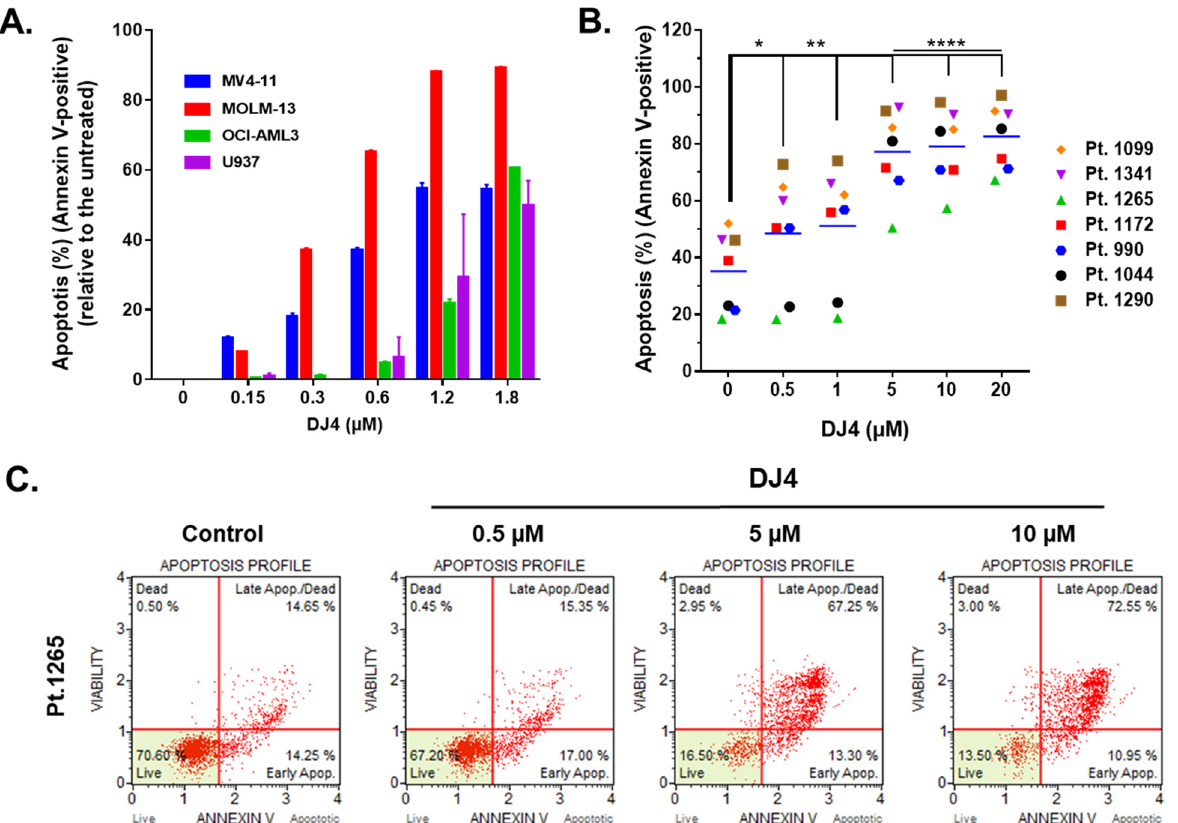
Figure 3. DJ4 treatment exerts a proapoptotic effect in AML cell lines and primary samples. ( A ) Induction of apoptosis was measured as a percentage of Annexin V-positive cells upon treating the human AML cell lines with increasing concentrations of DJ4 for 24 h. The values are reported as the means ± SEM. ( B ) The apoptotic effect in the AML primary patient samples was quantified as the percentage of Annexin V-positive cells after subsequent 24 h DJ4 treatment (see Figure S4 for the normalized plot). The data were analyzed via two-way ANOVA (Dunnett’s multiple comparisons test) to compare the grand mean apoptosis, indicated by the black line, of DJ4 treatment versus the control, wherein * p < 0.05, ** p < 0.01, **** p < 0.0001 were considered significant. ( C ) Representative flow plots of the live, dead, and apoptotic populations (early and late apoptosis) upon treating AML primary cells with DJ4 (0–10 μ M). The data are the result of two independent experiments.